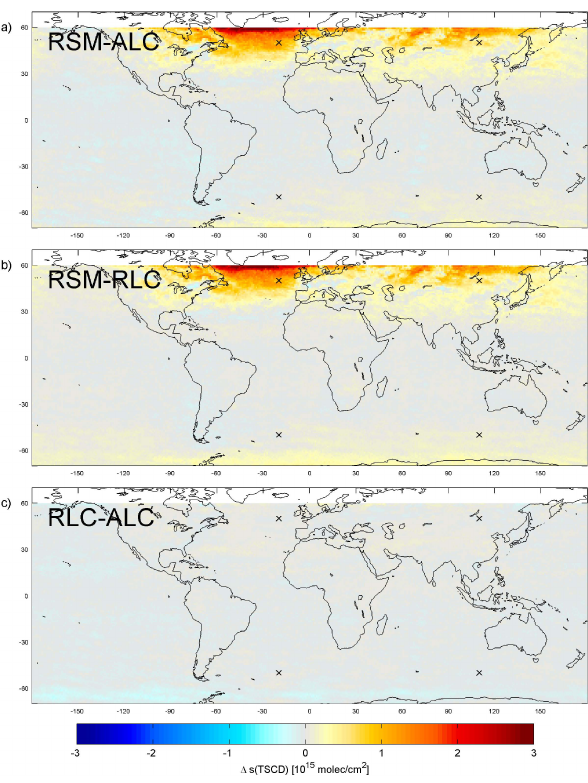
Fig. 10. Difference of the standard deviations of tropospheric SCDs s(T RSM ) − s(T ALC ) (a) , s(T RSM ) − s(T RLC ) (b) , and s(T RLC )